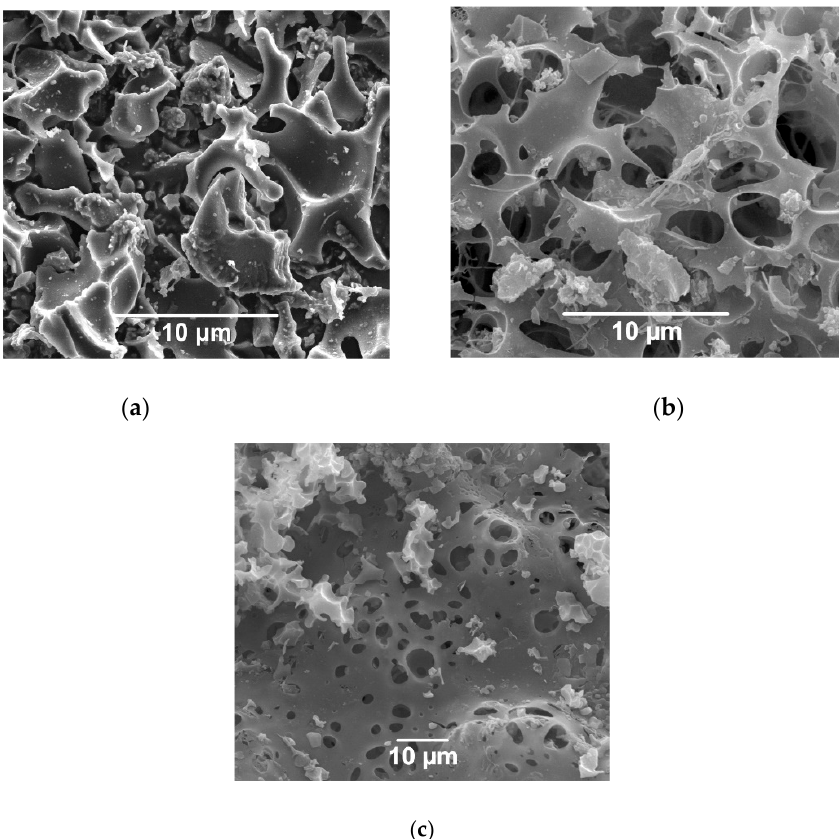
Figure 5. The microstructure of activated carbons prepared by chemical activation of olive stones with potassium hydroxide (CK), ( a ) without P. stutzeri , ( b ) P. stutzeri on CK surface, and ( c ) P. stutzeri on melamine-functionalized CK (CKN); surface estimated by SEM analysis.